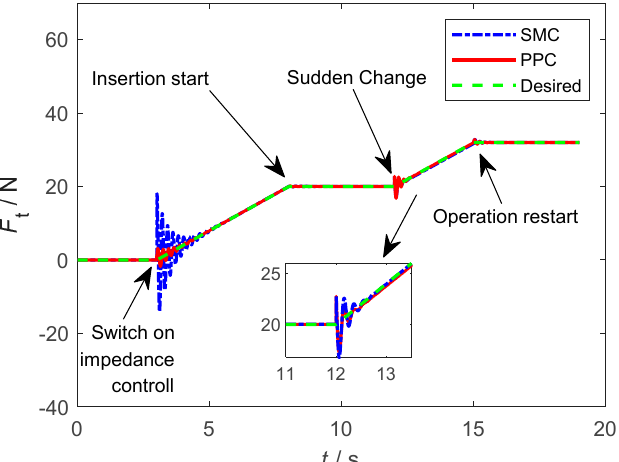
Figure 14. Output force of space robot end tracking curve of on-orbit insertion operation with friction change.